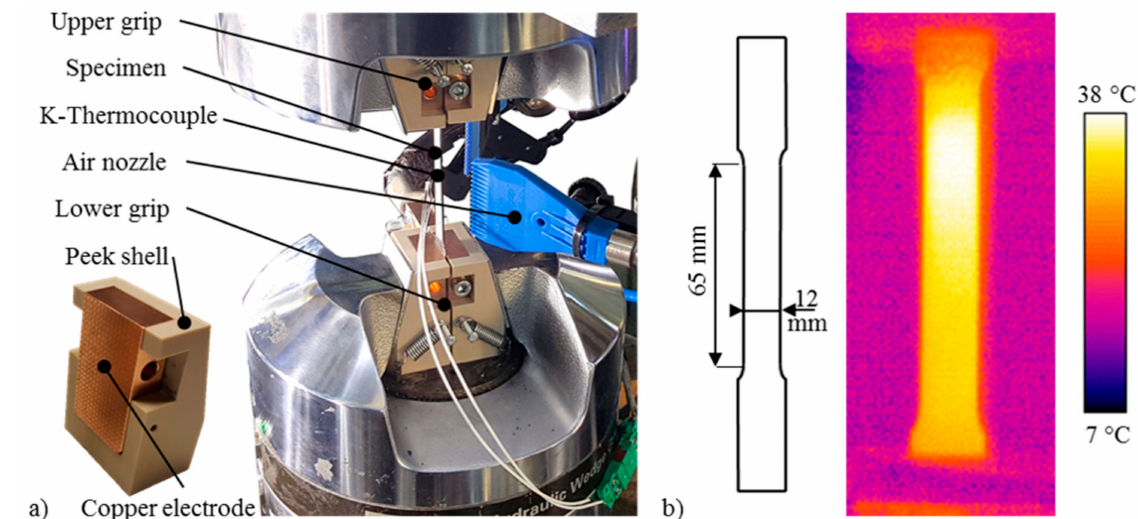
Figure 1. ( a ) Experimental set-up for the tensile tests and ( b ) sample geometry and example of temperature distribution in the sample (AA7075-SS 5 A/mm 2 ).